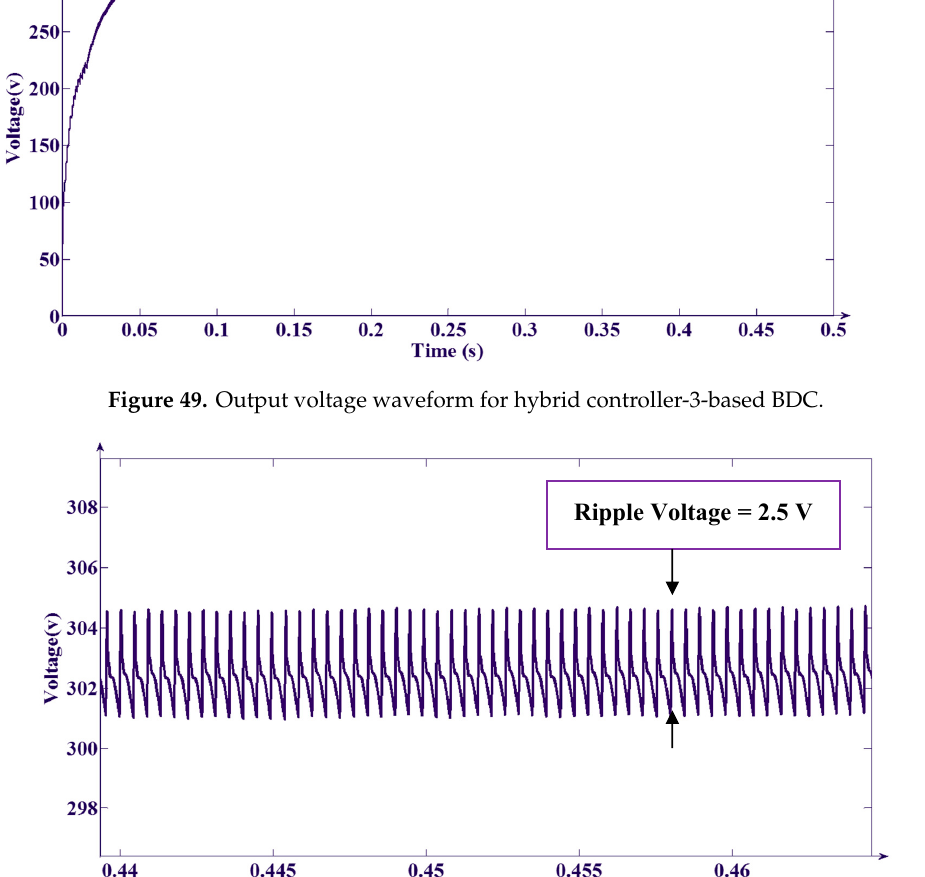
Figure 50. Output voltage ripple for hybrid controller-3-based BDC.